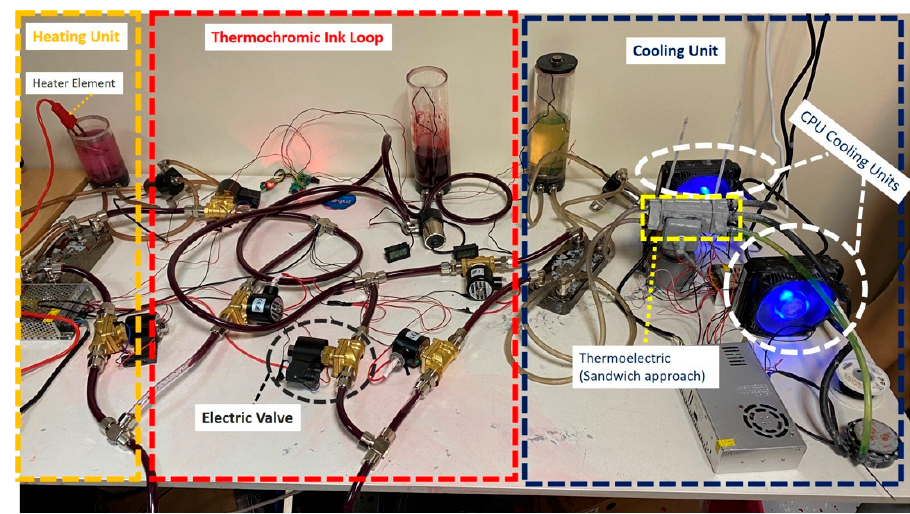
Figure 6. Overview of an enhanced version of the heater–cooler prototype (normal/oxygenation operation).